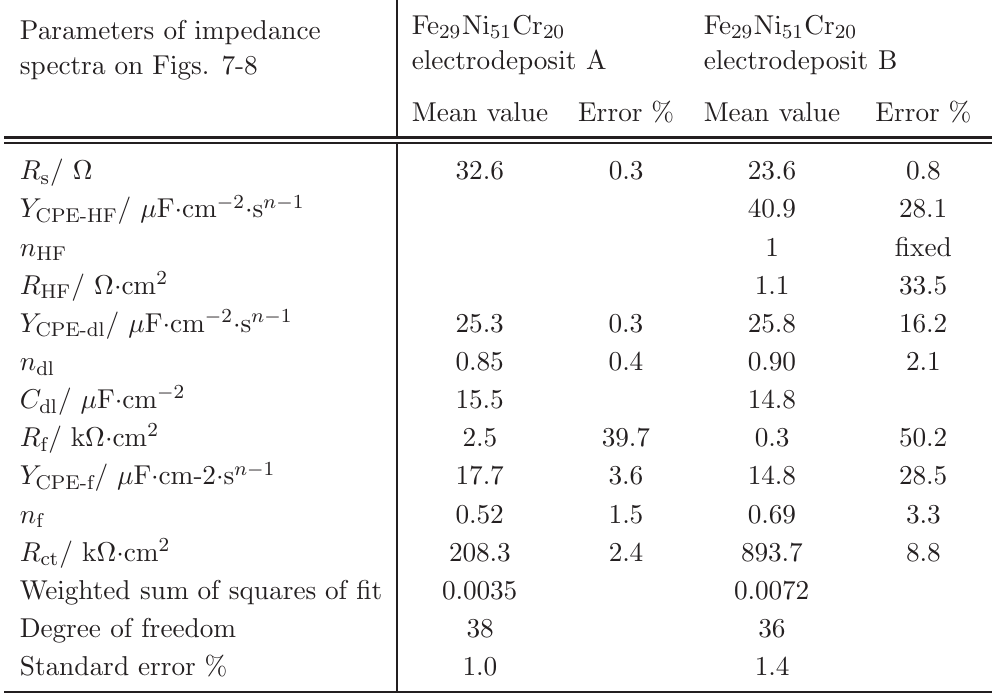
Table 3 Parameters used to fit the EIS spectra of Fe corresponding to the models of Figure 9 between 17 KHz and 24 mHz frequency range 1